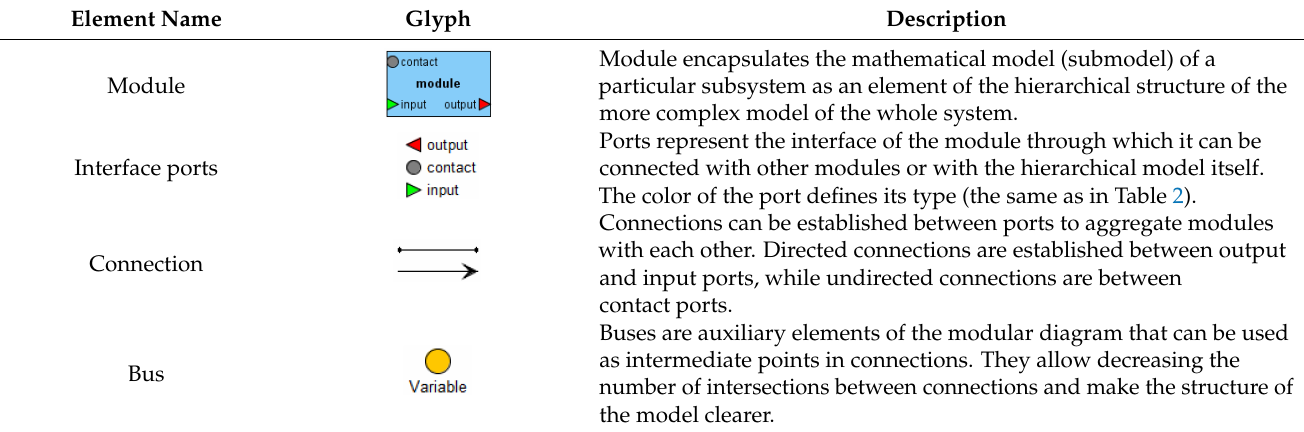
Table 3. Designation of the model elements on modular diagrams in the BioUML. Adapted from